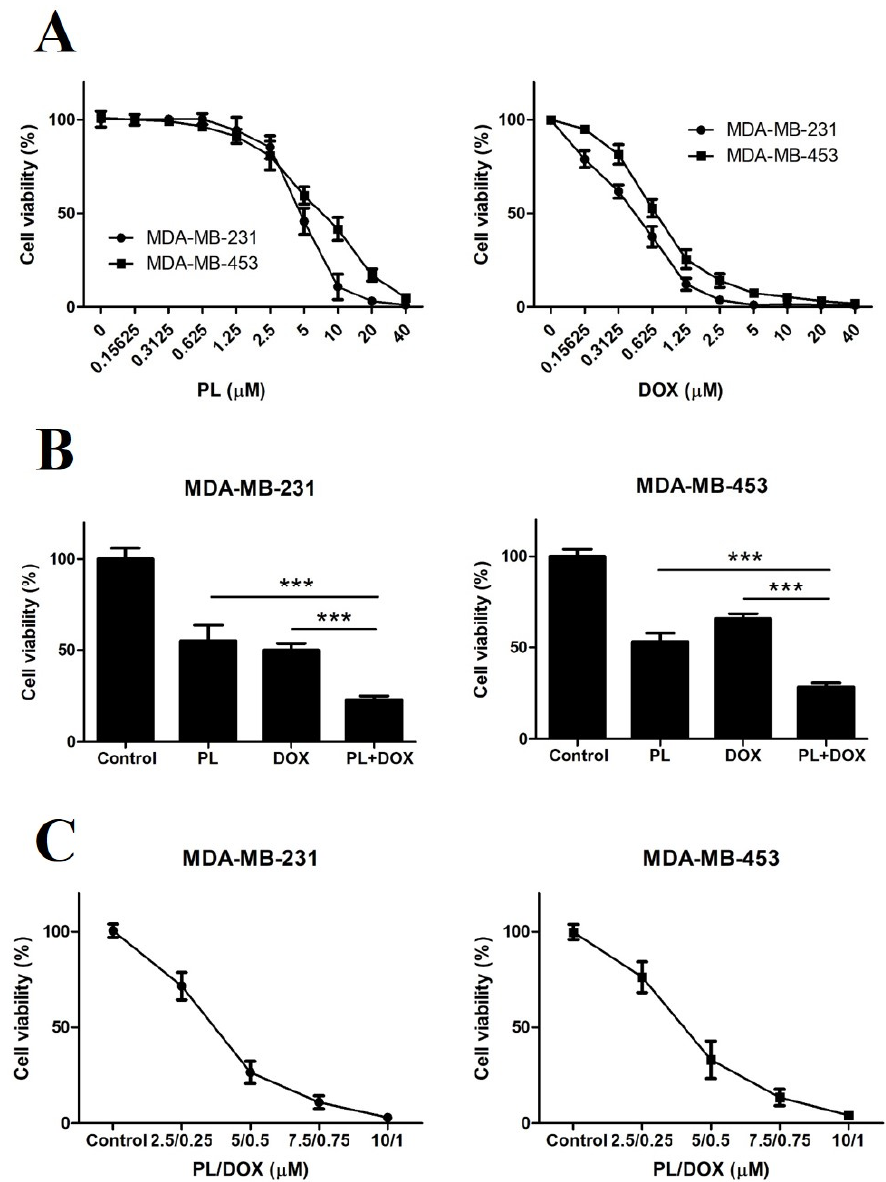
Figure 4. Piperlongumine and doxorubicin synergistically inhibit the proliferation of TNBC cells. ( A ) MDA-MB-231 and MDA-MB-453 cells were treated with various concentrations of PL or DOX for 72 h, and DMSO was used as a vehicle control. Cell viability was detected by MTT. ( B ) Both cells were treated with DMSO, 5 µ M PL, 0.5 µ M DOX, or in combination for 72 h. Cell viability was detected by MTT. The CI was calculated using CompuSyn. The CI values of the combination treatment were 0.57 in MDA-MB-231 cells and 0.61 in MDA-MB-453 cells. ( C ) Combination treatment of PL and DOX inhibited the growth of TNBC cells in a dose-dependent manner. Both TNBC cell lines were treated with the indicated concentrations of PL and DOX for 72 h, and cell viability was detected by MTT. *** p < 0.001 compared to the